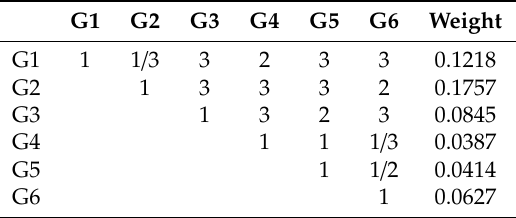
Table A4. Pairwise comparison matrix of Government Support.